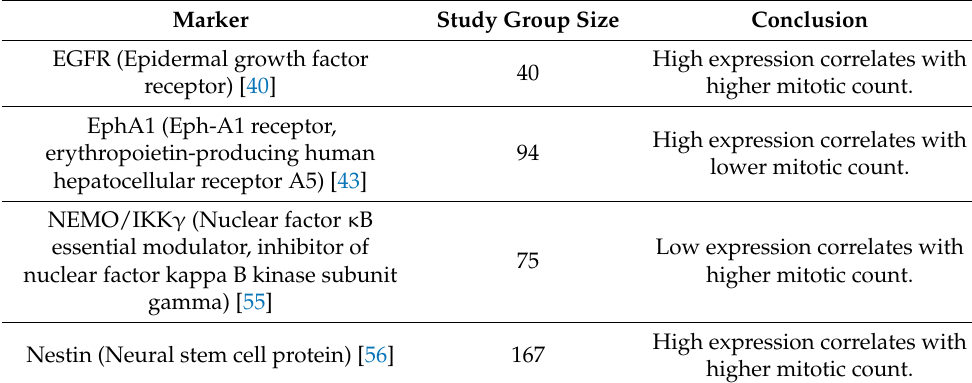
Table 7. Summary of markers whose expression is related to mitotic